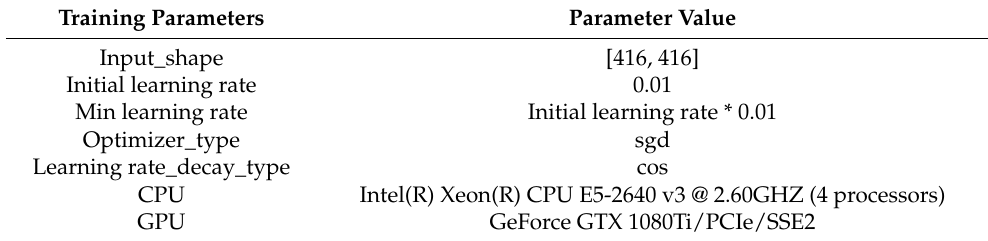
Table 1. Training parameters and